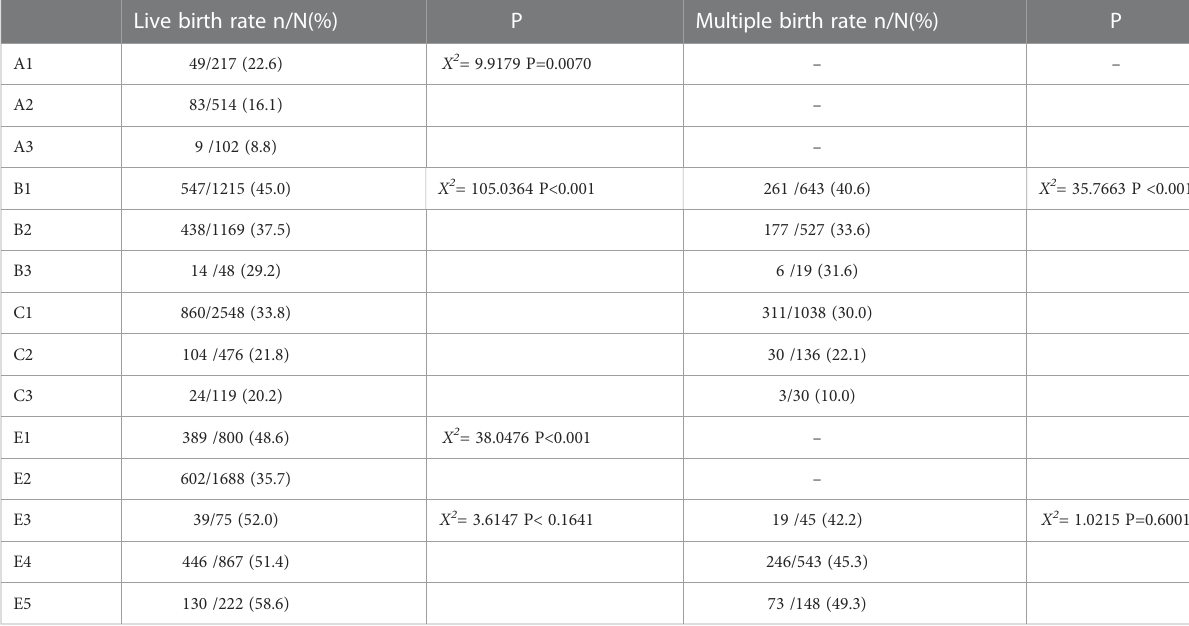
TABLE 4 Live birth rate and multiple birth rate of different embryo transfer groups.